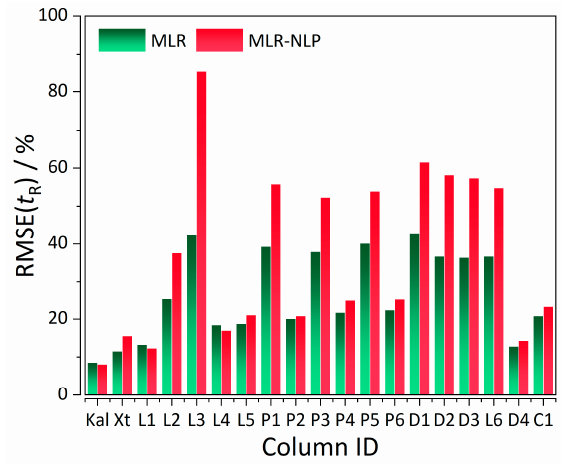
Figure 2. QSRR model performance expressed in terms of %RMSE( t R ) for MLR (control) and MLR-NLP models. Legend: Kal—Supelcosil LC18, t G = 10 min, T = 35 °C (case study 1); Xt—Xterra, t G = 20